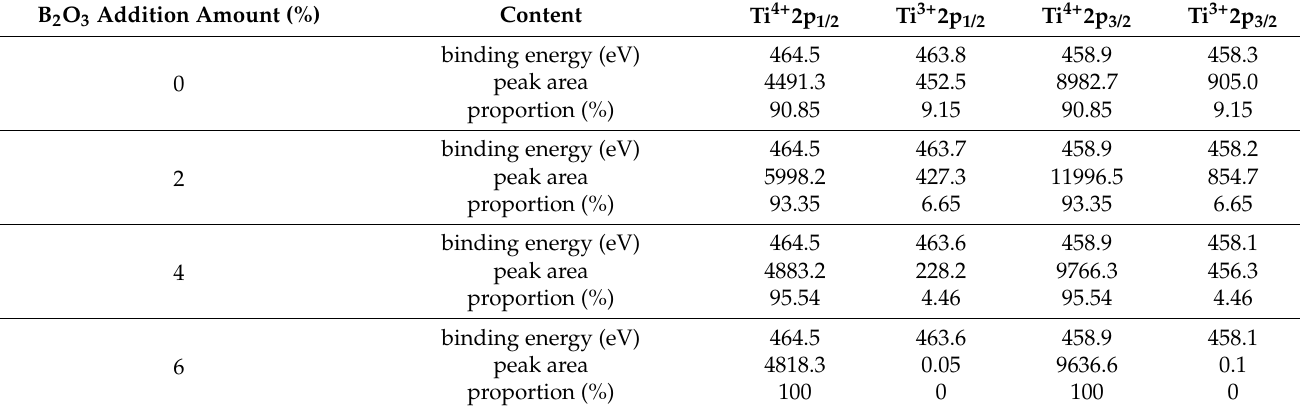
Table 3. Peak positions of photoelectron peaks of Ti 3+ and Ti 4+ in titanium oxide in the literature.